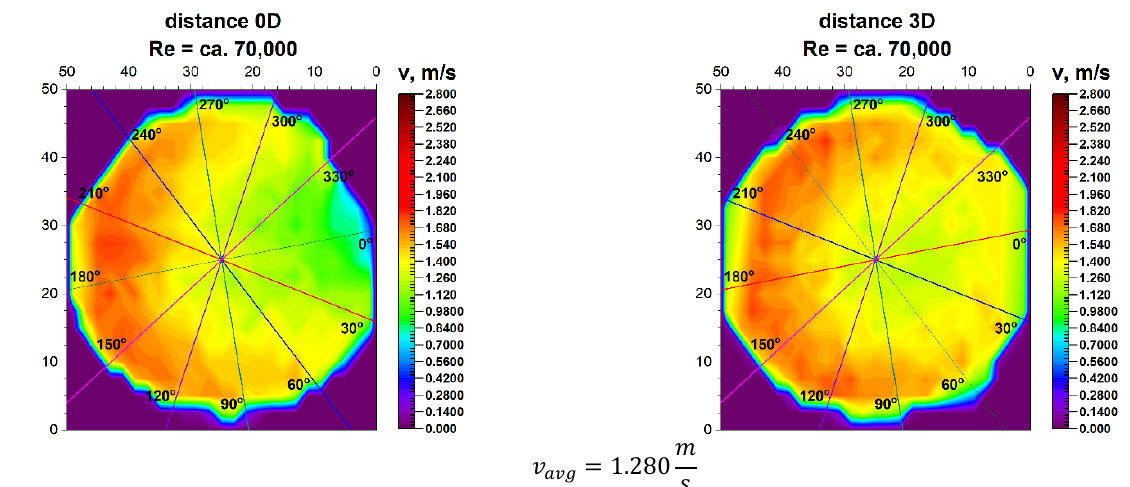
Figure 7. Comparison of projection on the velocity blocks at a distances 0D and 3D from the disturbance with marked cross-sections for Re ≅ 70,000.